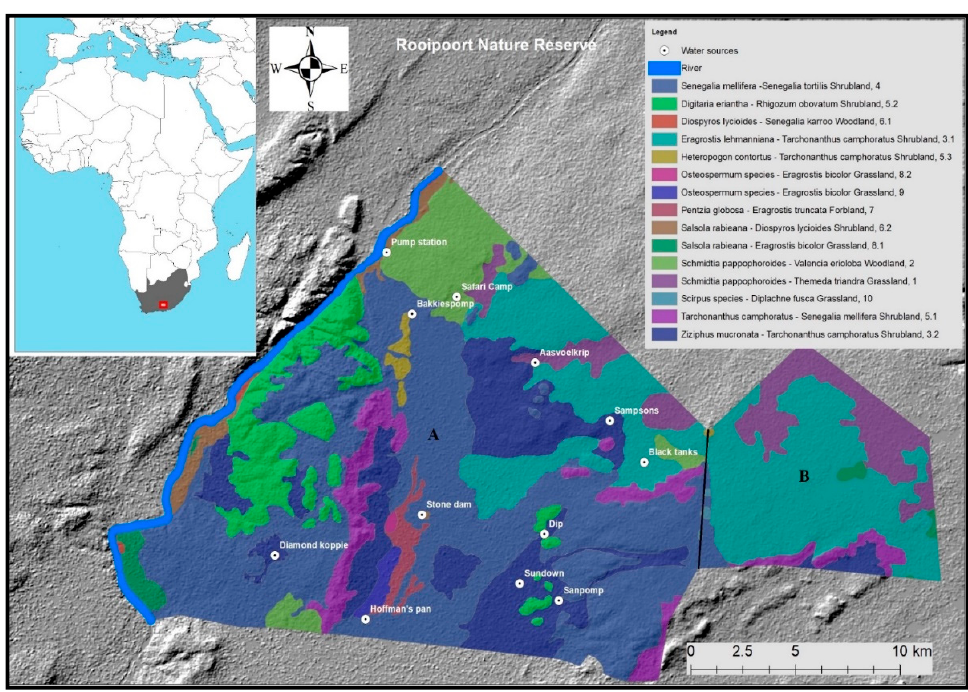
Figure 1. Study site (area A) at Rooipoort Nature Reserve including a vegetation map (identified by Bezuidenhout, 2009) and permanent waterhole locations on a digital elevation topography map. Area B is fenced off and inaccessible for giraffes.